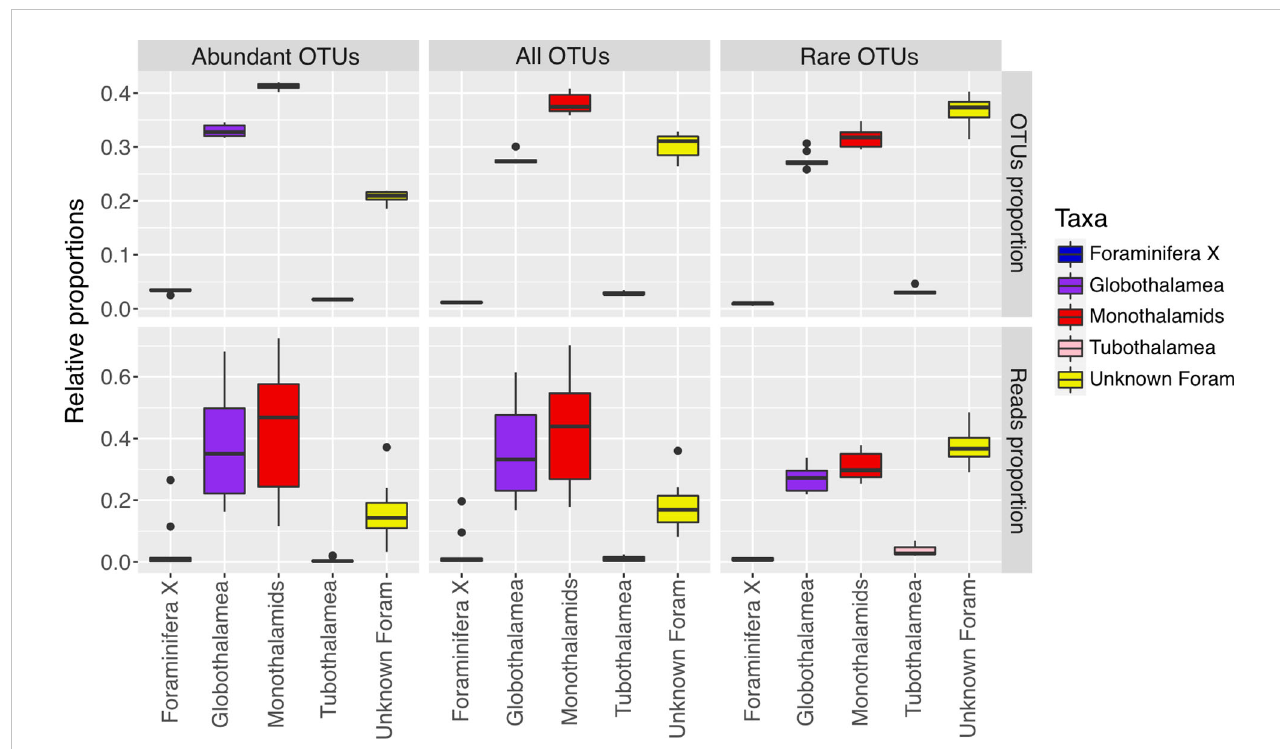
FIGURE 2 Proportions of OTUs and reads assigned to different taxonomic groups at the class level in abundant, rare and all